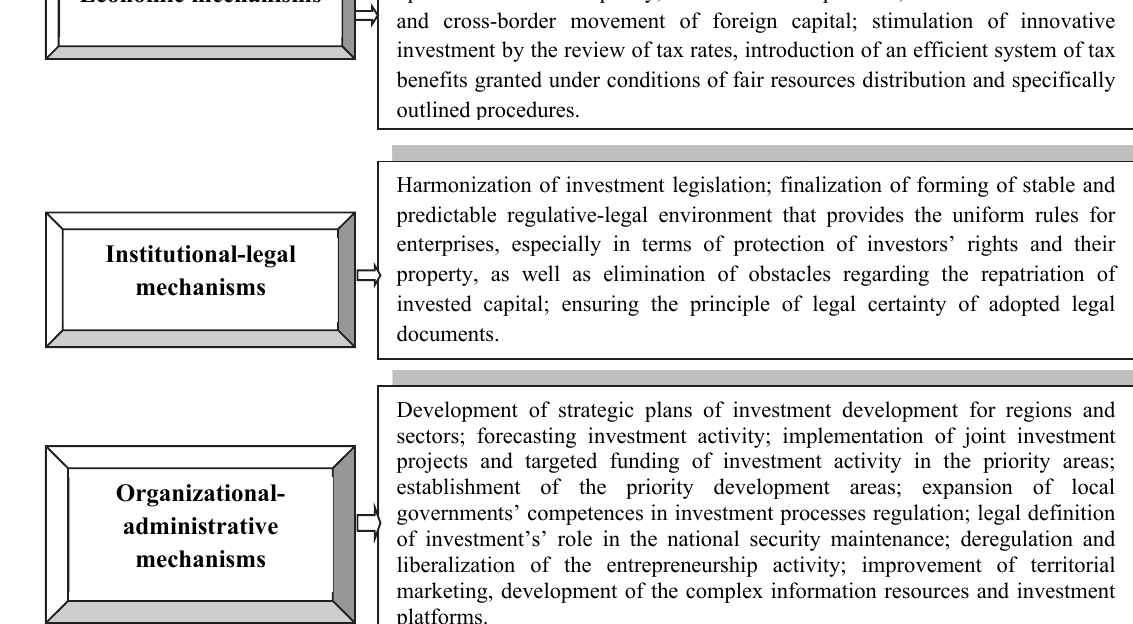
Fig. 1. Mechanisms of the investment climate improvement in Ukrainian regions at the stage of economy destabilization Source: calculated by